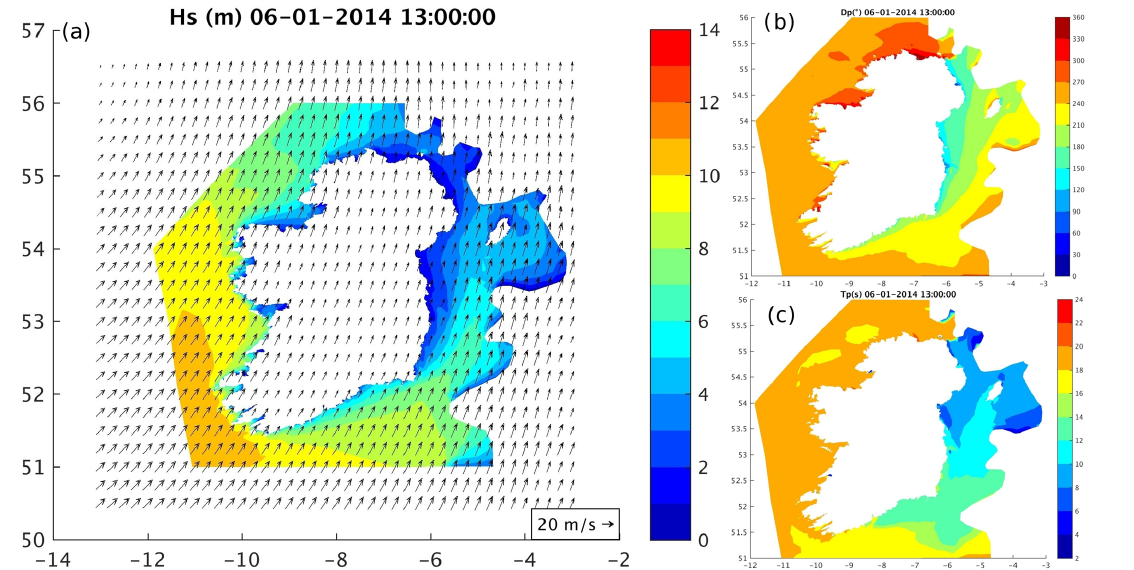
Figure 12. Maps of (a) significant wave height (m) with vectors representing wind speed (ms − 1 ) and direction ( ◦ ), (b) peak wave direction ( ◦ ), and (c) peak wave period (s) at 13:00UTC on 6 January 2014 during storm “Hercules”.